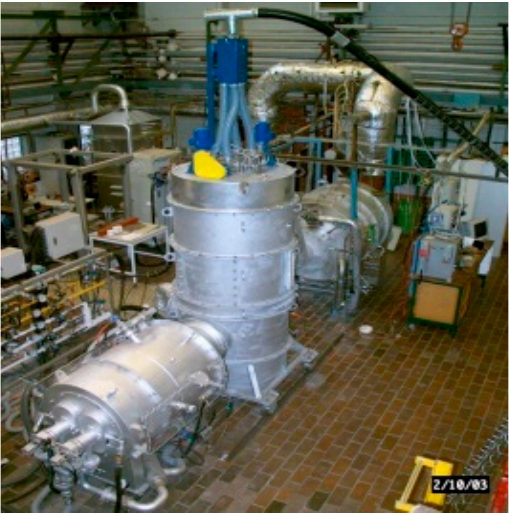
Figure 8. Experimental stand for continuous downdraft gasification.